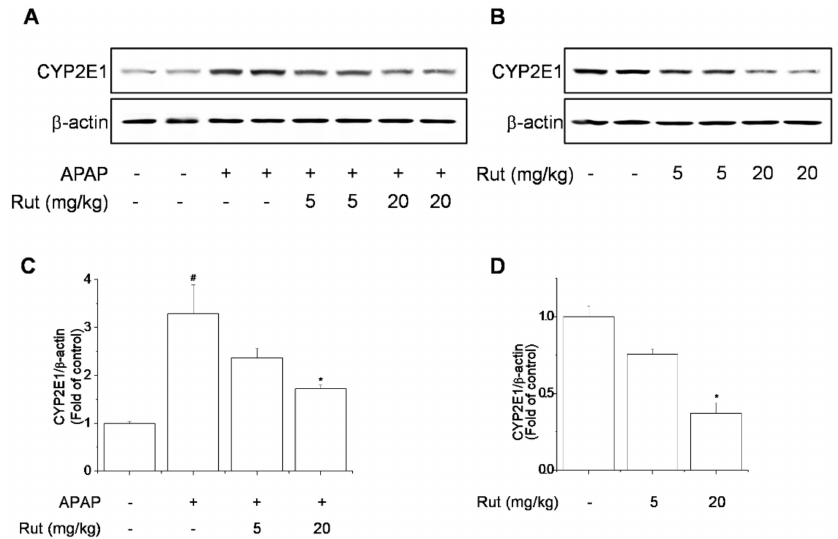
Figure 2. Protective effect of Rut in APAP-induced CYP2E1 expression in mice. CYP2E1 protein levels were determined using western blotting ( A , B ). Protein level was analyzed using ImageJ software. Relative expression of the target protein was compared using β -actin as a control ( C , D ). Results are indicated as means ± SD ( n = 10). # Significantly different from the control ( p < 0.05). * Significantly different from the APAP-treated group ( p < 0.05).